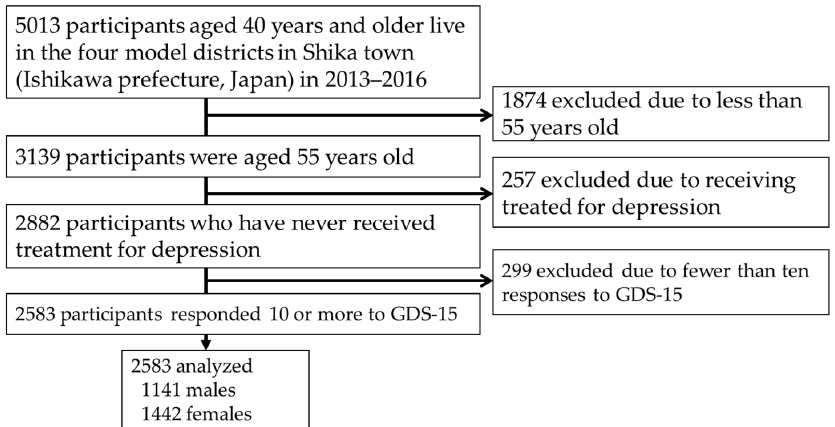
Figure 1. Participant recruitment chart. Abbreviations: GDS, Geriatric Depression